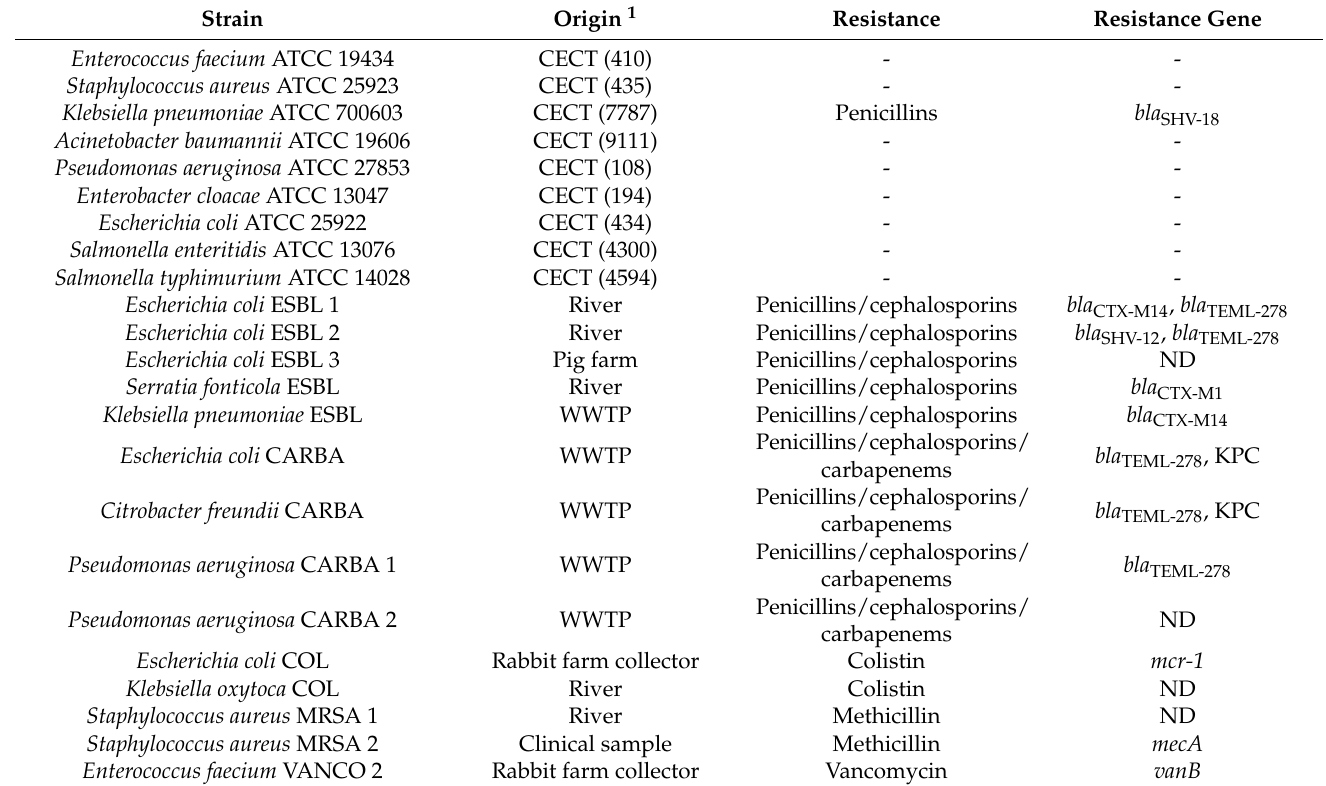
Table 3. Strains used in agar well-diffusion antibacterial assays and their characteristics.